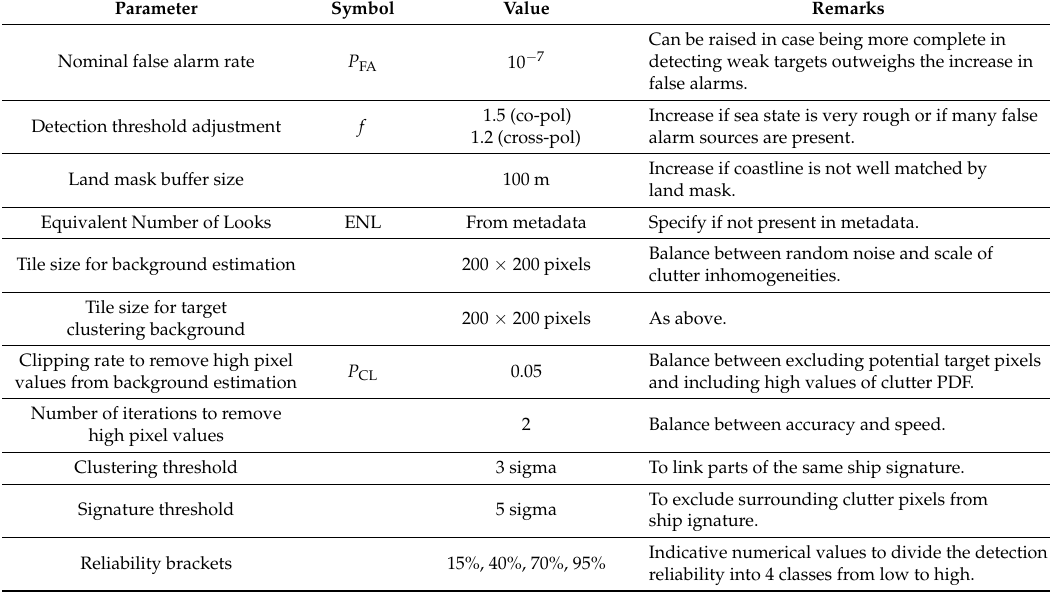
Table 3. Parameters used in Search for Unidentified Maritime Objects